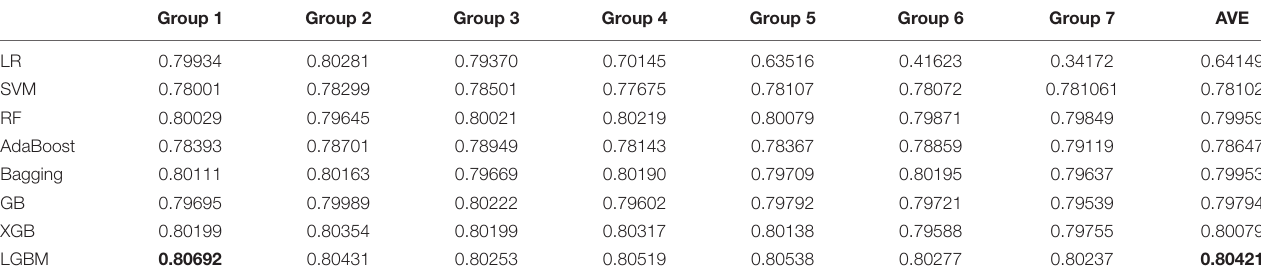
TABLE 5 | Relaxation model training ACC results.